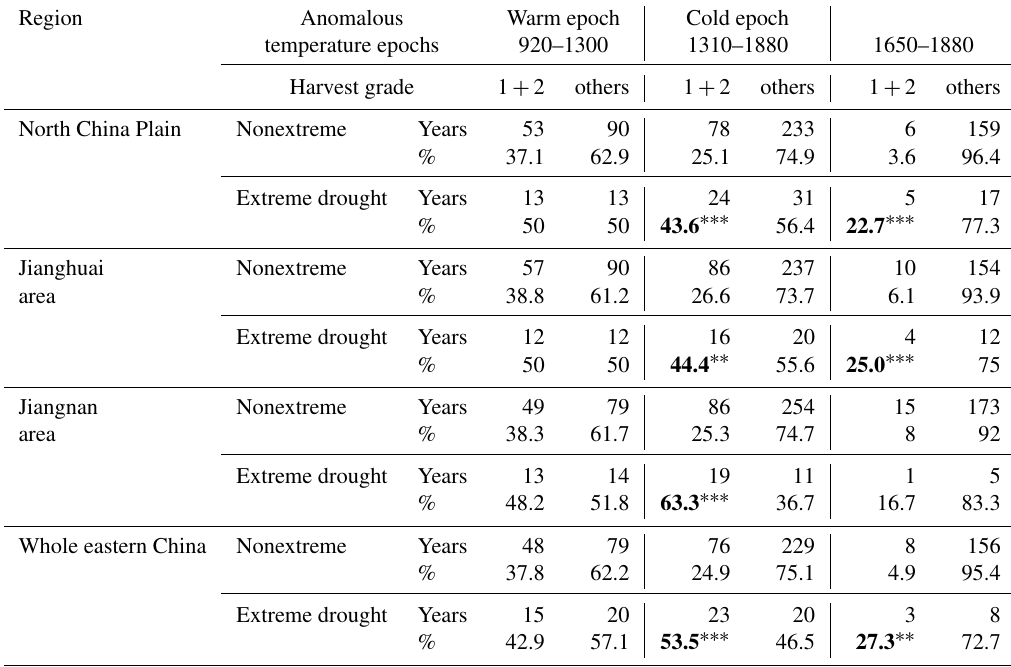
Table 6. Comparison of frequency of reconstructed poor harvest (grade 1 + 2) for extreme drought years and nonextreme years for warm and cold